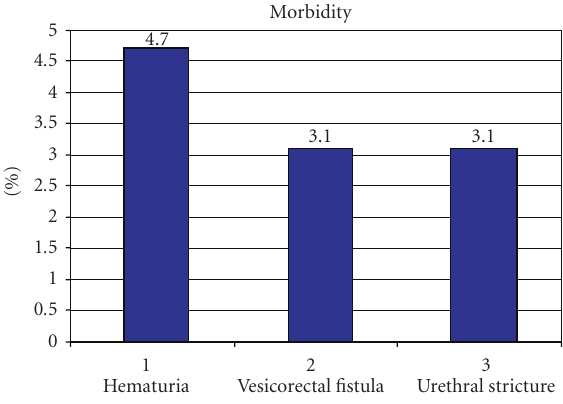
Figure 5: Complications in 64 patients with penetrating bladder